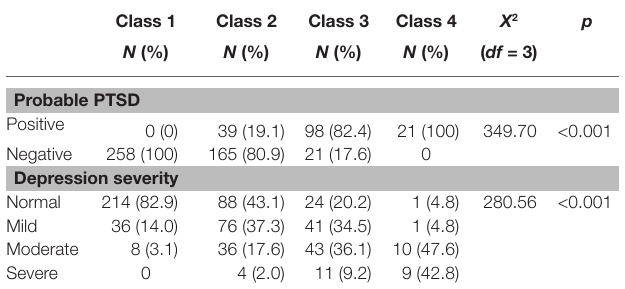
TABLE 3 | Difference in symptom severity among classes by chi-square